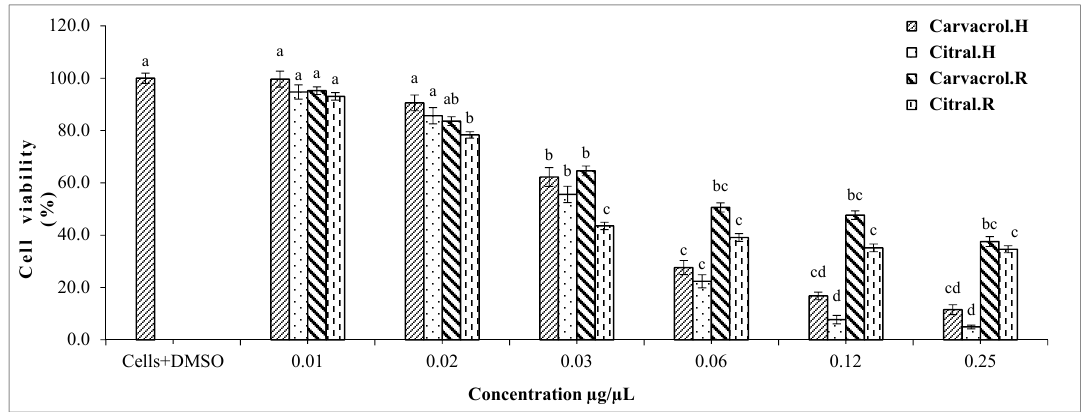
Figure 3. Viability percentage of HepG2 and HEK293 cells after treatment with different concentrations of citral and carvacrol. Bars with different letters for each single substance indicate mean values significantly different at p < 0.05 according to Tukey (B) test. Data are expressed as mean of three replicates ± SD. Where: carvacrol.H: liver cells treated with carvacrol; citral.H: liver cells treated with citral; carvacrol.R: renal cells treated with carvacrol; citral.R: renal cells treated with citral. Molecules 2017 , 22 , 1435